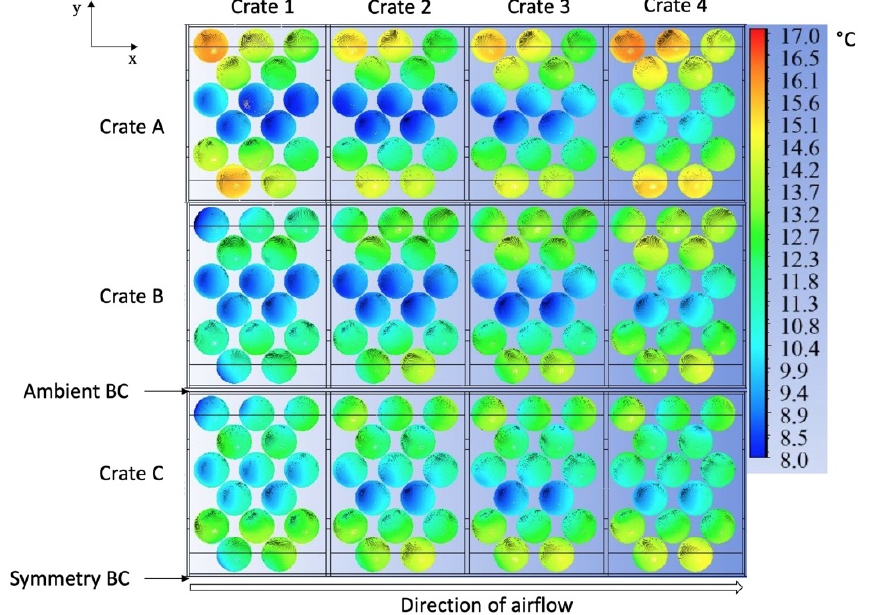
Figure 17. Influence of crate design on the temperature uniformity of the product at a pressure drop of 4.5 Pa at HCT.